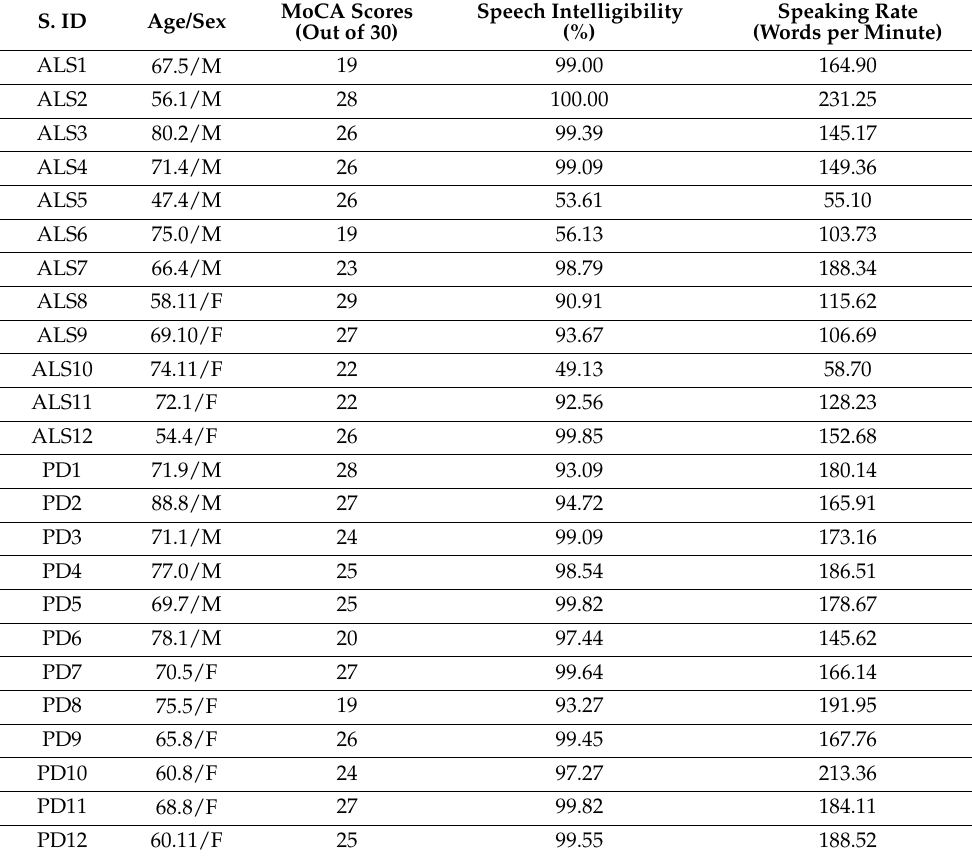
Table 1. Demographic and clinical details of participants in the ALS and PD